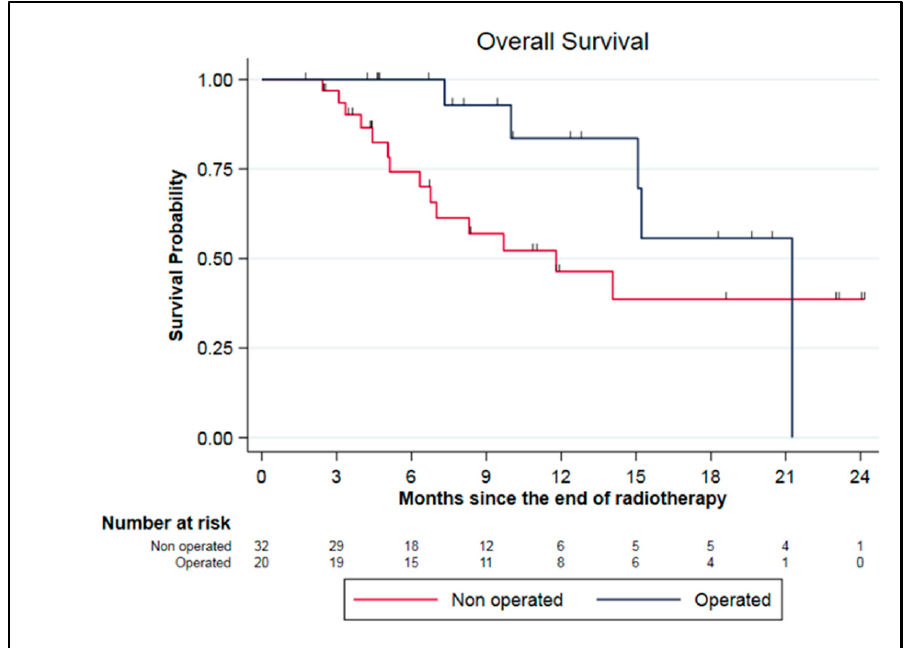
Figure 4. Survival data for LAPC and BRPC patients: comparison between resected and unre- sected patients.